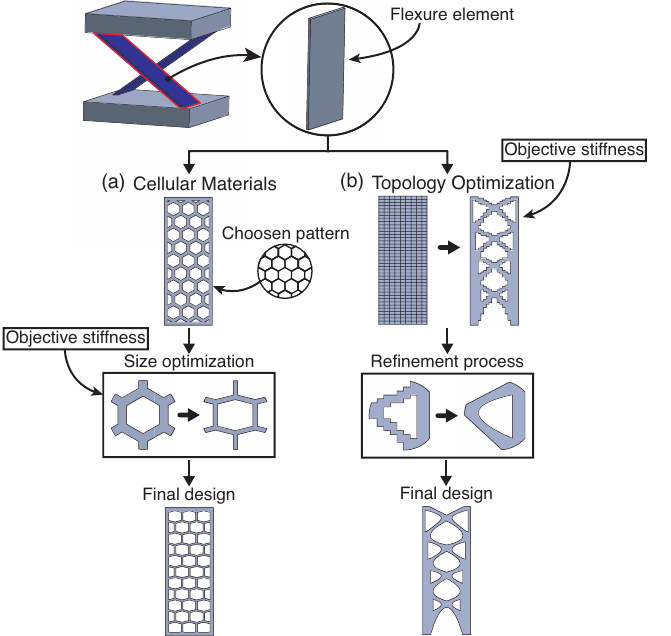
Figure 2. Process to tailor stiffness of flexure elements via ( a ) Cellular Materials and ( b ) Topology Optimization (Figure based on that in